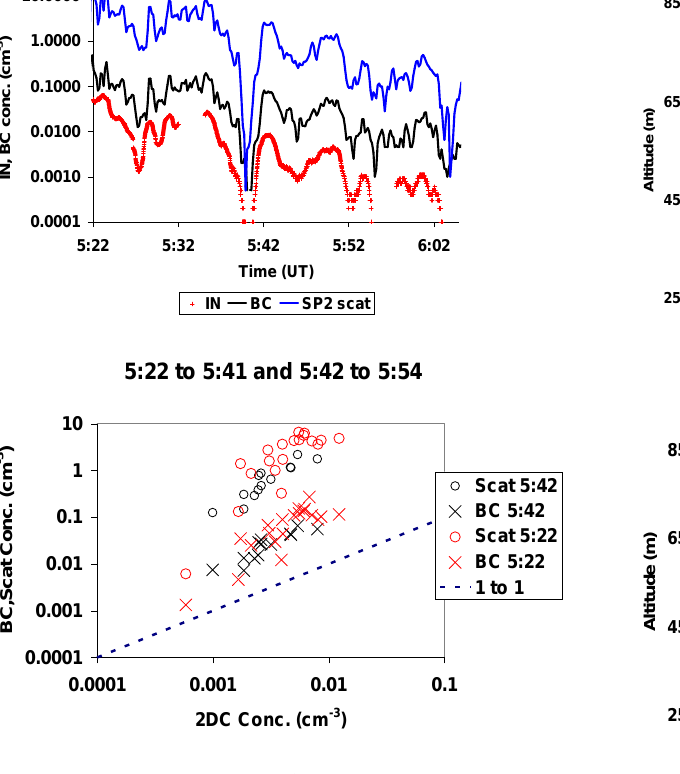
Fig. 9. Number concentrations of total SP2 scattering, rBC and IN concentrations in CVI residuals versus time (top). 60s average values versus 2DC concentration (bottom) for the indicated time periods.